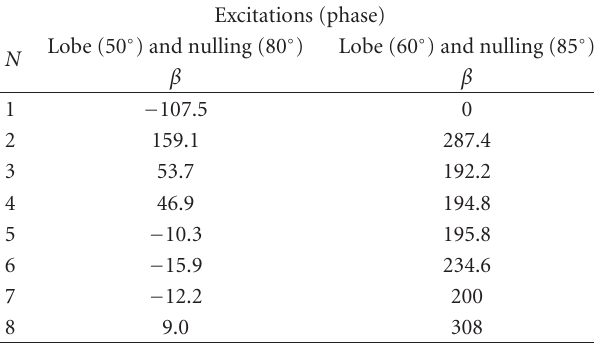
Table 3: Steering one lobe and nulling.